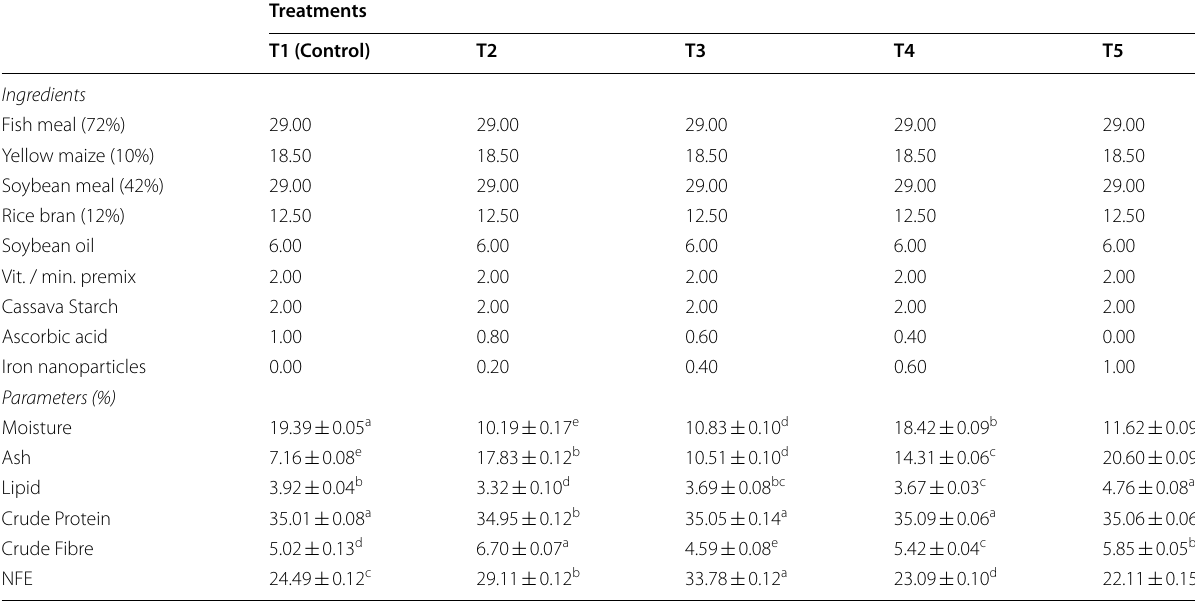
Table 1 Composition of the experimental diet in g/100 g dry matter containing various inclusion levels of ascorbic acid and iron nanoparticles for C.